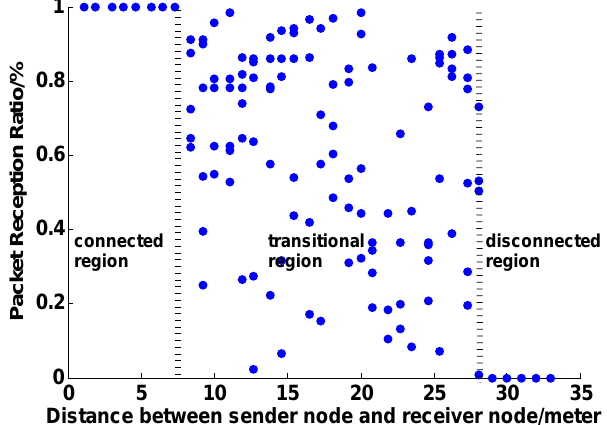
Figure 1. The spatial characteristic of wireless links.